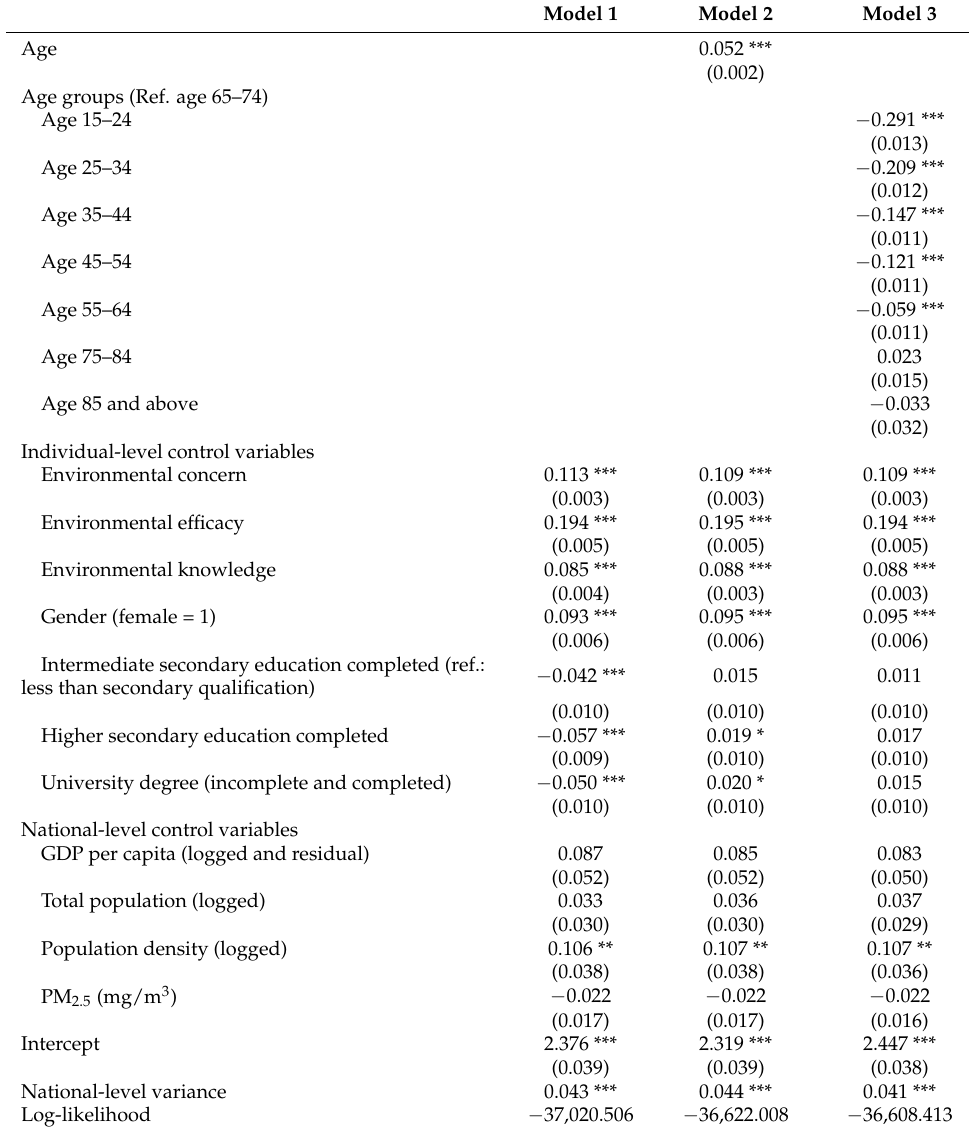
Table 3. Multilevel linear models predicting pro-environmental behavior,